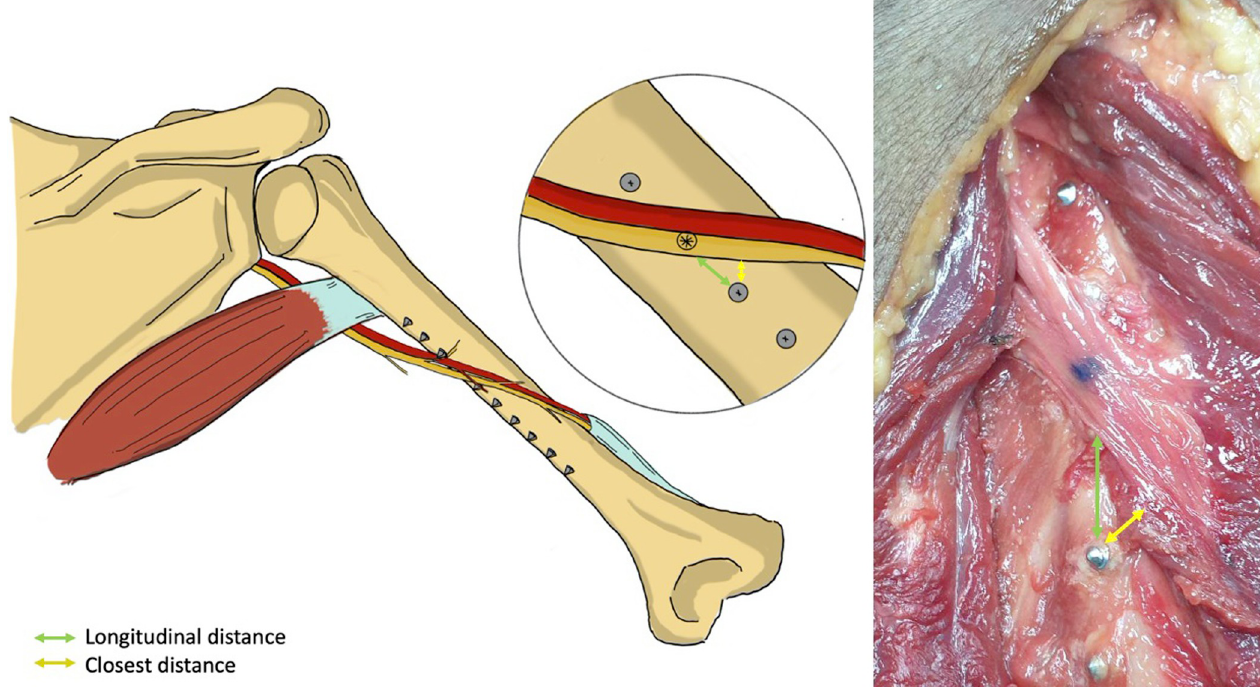
Fig 4. Posterior view of a right upper arm; the distances from the screw holes to the neurovascular structure were measured in the longitudinal plane (green line) and closest plane (yellow line).